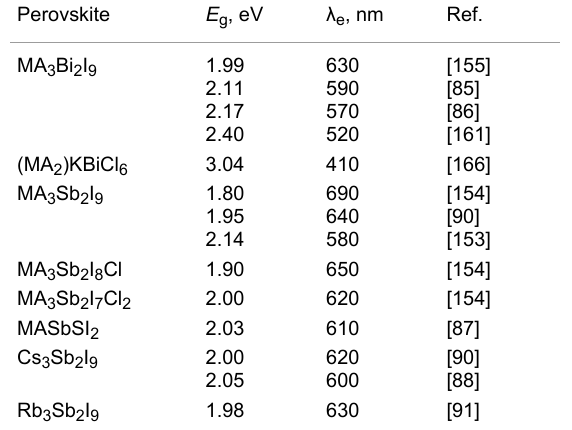
Table 3: Bandgap and approximate absorption band edge position ( λ e ) of selected Bi- and Sb-based hybrid perovskites. Perovskite E g , eV λ e , nm